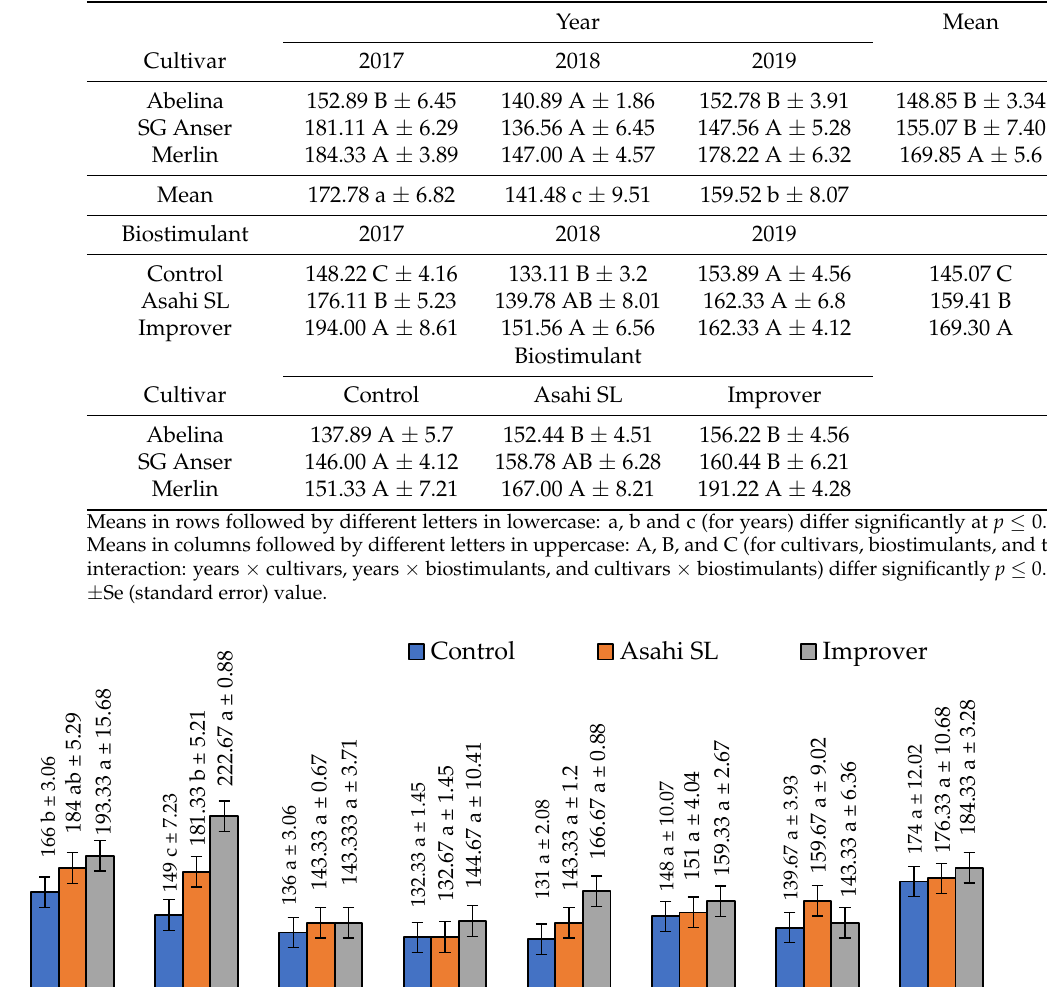
Table 4. 1000-seed weight according to years, cultivars and biostimulants (gha − 1 ).